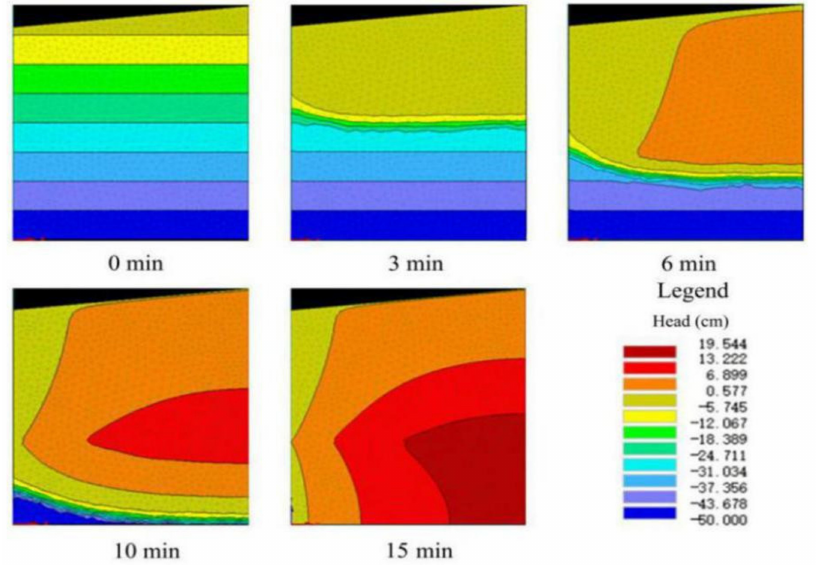
Figure 7. Simulation results of the water quantity